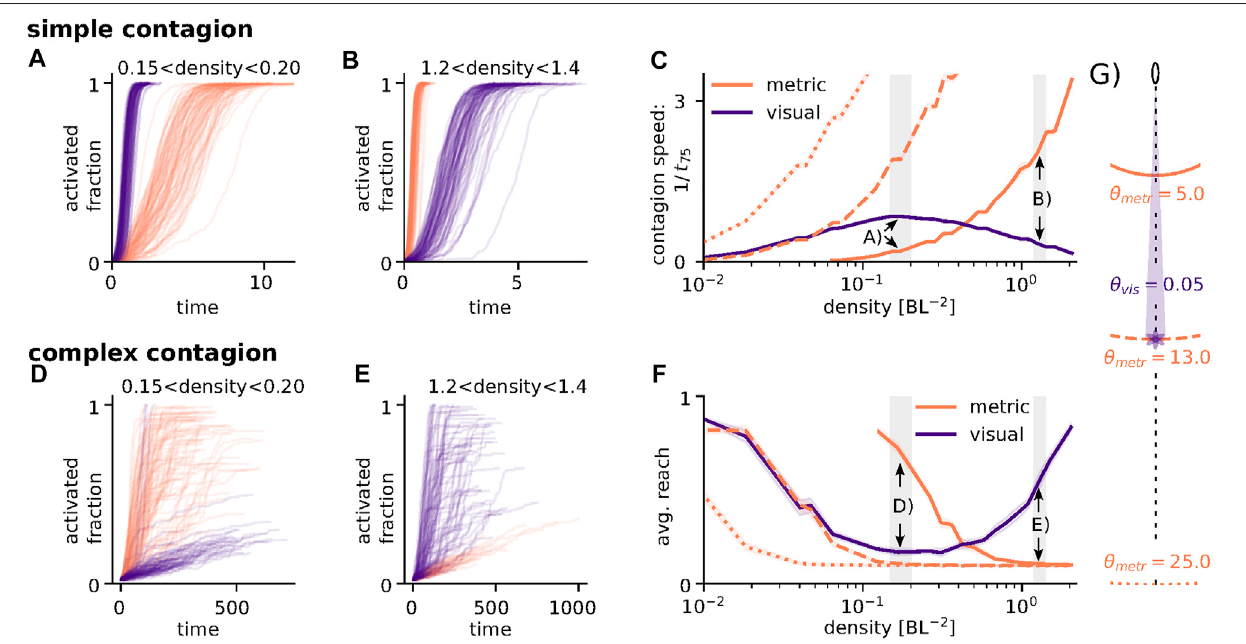
FIGURE 4 | Simple and complex contagion on visual and metric networks. (A) Example trajectories for a simple contagion process at low densities for visual (purple) and metric (orange) networks showing faster spread in metric networks. (B) same as (A) but for high densities showing faster spread for visual networks. (C) Comparison of visual and metric network with respect to the speed of infection via simple contagion. In metric networks the speed of spread increases monotonically with density. In visual networks the contagion speed assumes a maximum at intermediate densities. Line-styles correspond to different thresholds of the metric networkasillustratedin(G).Shaded grey areas correspond tothedensity rangesin(A)and(B)respectively. (D) Exampletrajectoriesforacomplexcontagionprocessat low densities showing faster spread in metric networks. Note, that most trials do not reach full activation in either network type. (E) Same as (D) for high densities, showing faster spread in visual networks. Again, most trials do not reach full activation. (F) Comparison of average reach (i.e., fi nal fraction of activated individuals) as a functionofdensityforbothnetworktypes.Inmetricnetworksaveragereachdecreaseswithdensity,whilevisualnetworksshowaminimumatintermediatedensities.As in(C)line-stylescorrespondtodifferentmetricthresholdsandshadedareas correspondtotheexamplesin(D)and(E)respectively. (G) Illustration ofdifferentthresholds. Parameters: N (cid:1) 225, Φ ∈ [0,0.3], γ (cid:1) 0.03, β (cid:1) 0.3, r 0 (cid:1) 0.35, σ (cid:1) 10.Linesin(C)and(F)areaveragesover100networksand100runspernetwork,startingthecontagion process with one (simple contagion) or fi ve (complex contagion) randomly chosen